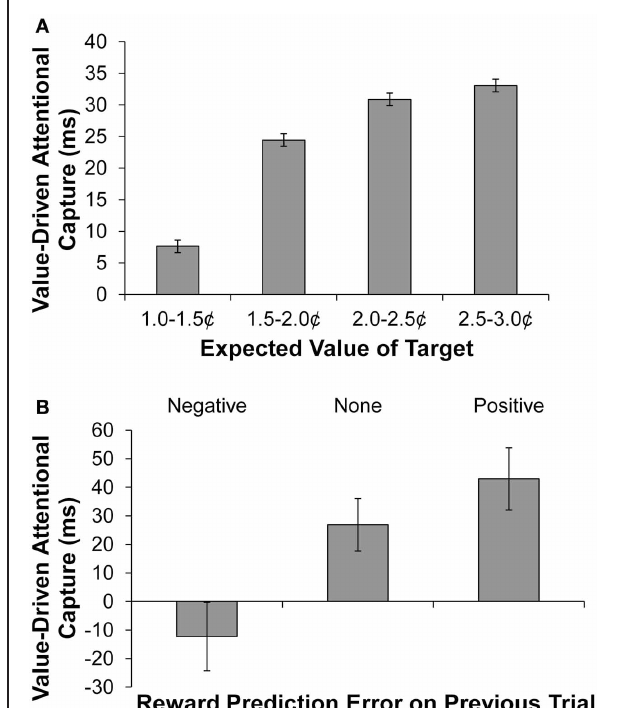
FIGURE 2 | Behavioral results. (A) Value-driven attentional capture (defined as the mean difference in RT between distractor-present and distractor-absent trials) as a function of the value of the search context (defined as the mean reward obtained on the previous 5 trials in which the current shape singleton served as the target). (B) Value-driven attentional capture as a function of the reward-prediction error experienced on the previous trial. The error bars reflect the within-subjects